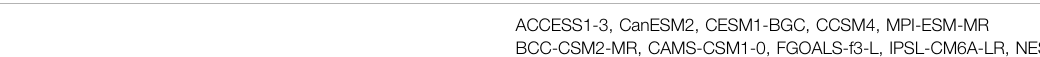
TABLE 2 | The selected representative models. Projects Models